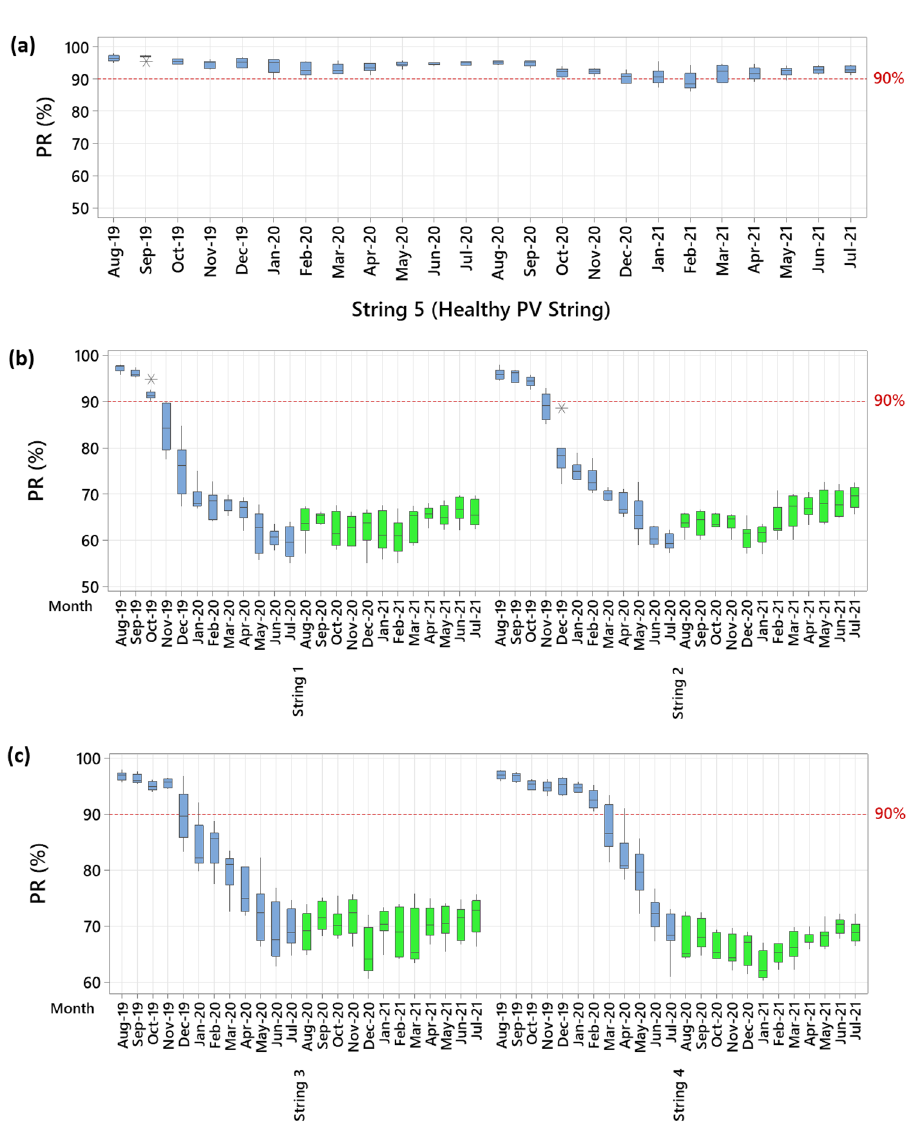
Figure 7. Performance ratio of the tested PV strings. ( a ) Healthy PV string (PV string 5). ( b ) PV strings 1 and 2. ( c ) PV string 3 and 4. The y-axis presents the PR ratio, and the baseline of 90% was selected to indicate low performance; the x-axis gives the month and the PV string number. This chart shows the PR ratio for the PV strings during their two years in the field, as well as the PR ratio after the anti-PID box is